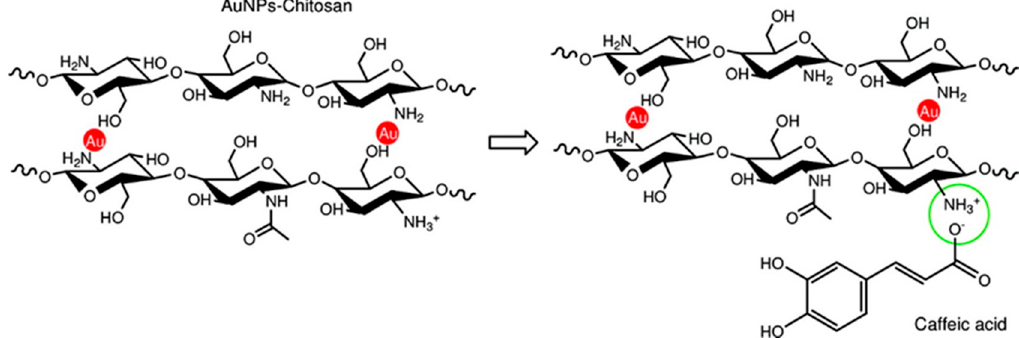
Figure 2. Schematic representation of the interaction between AuNPs/chitosan nanocomposite and caffeic acid. Reprinted with permission from [66] Copyright 2012, American Chemical Society .